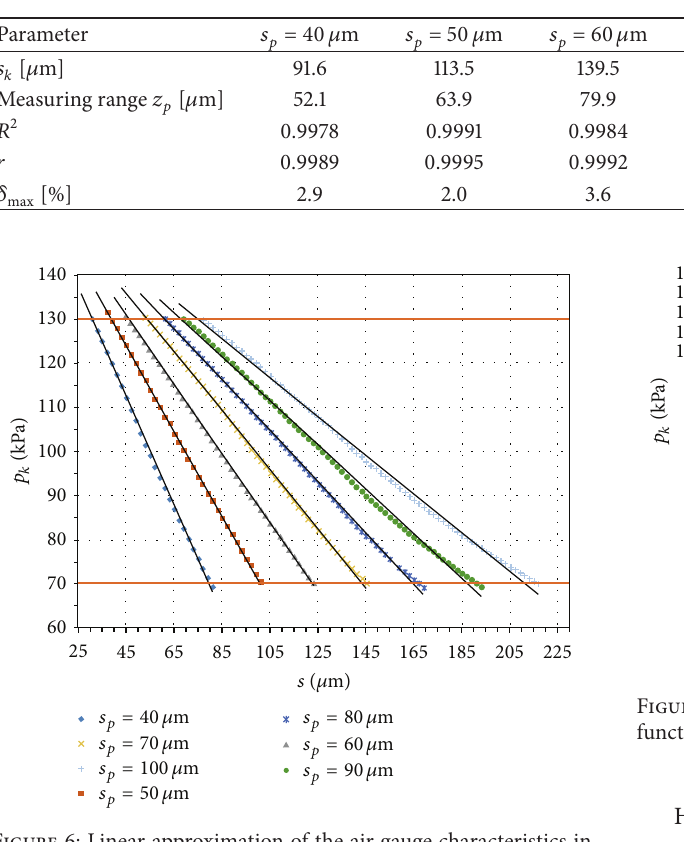
Figure 6: Linear approximation of the air gauge characteristics in the pressure range between 120 and 60 kPa.